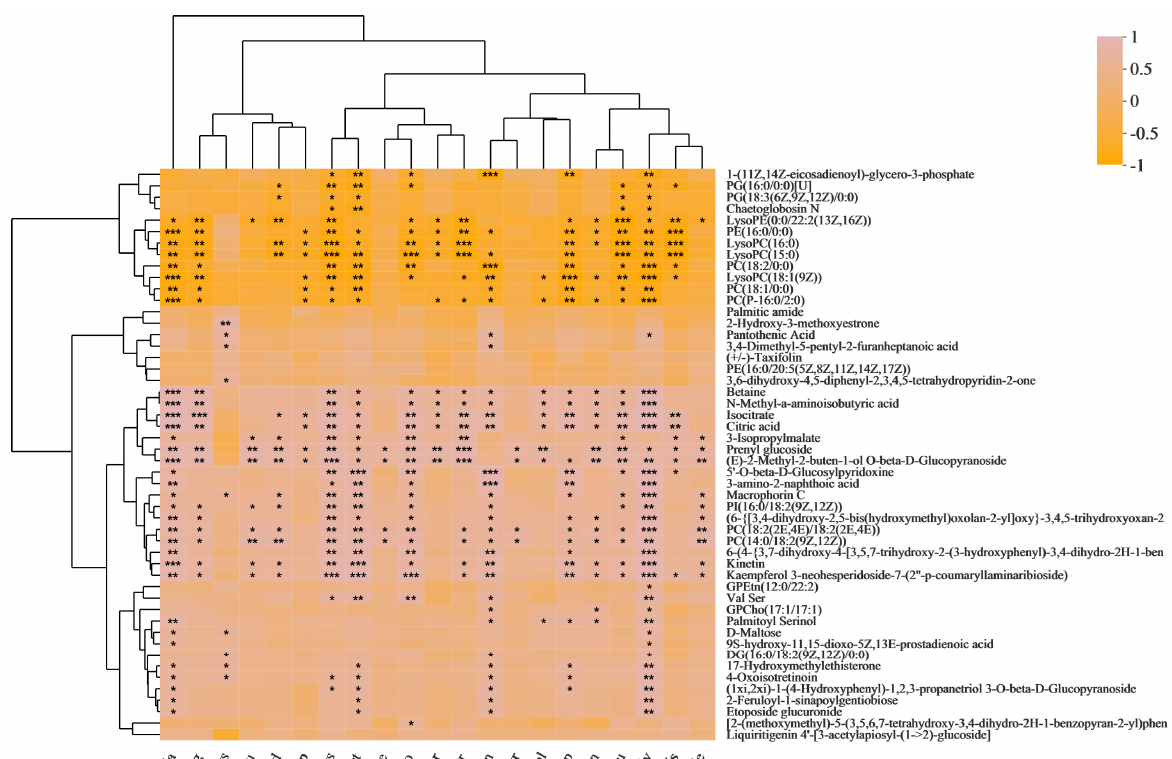
Figure 1. Correlation analysis of amino acids with differential metabolites (DMs). Each grid represents the correlation between the two attributes, and different colors represent the sizes of the correlation coefficients between the attributes (the same applies below). * p < 0.05; ** p < 0.01; *** p < 0.001.